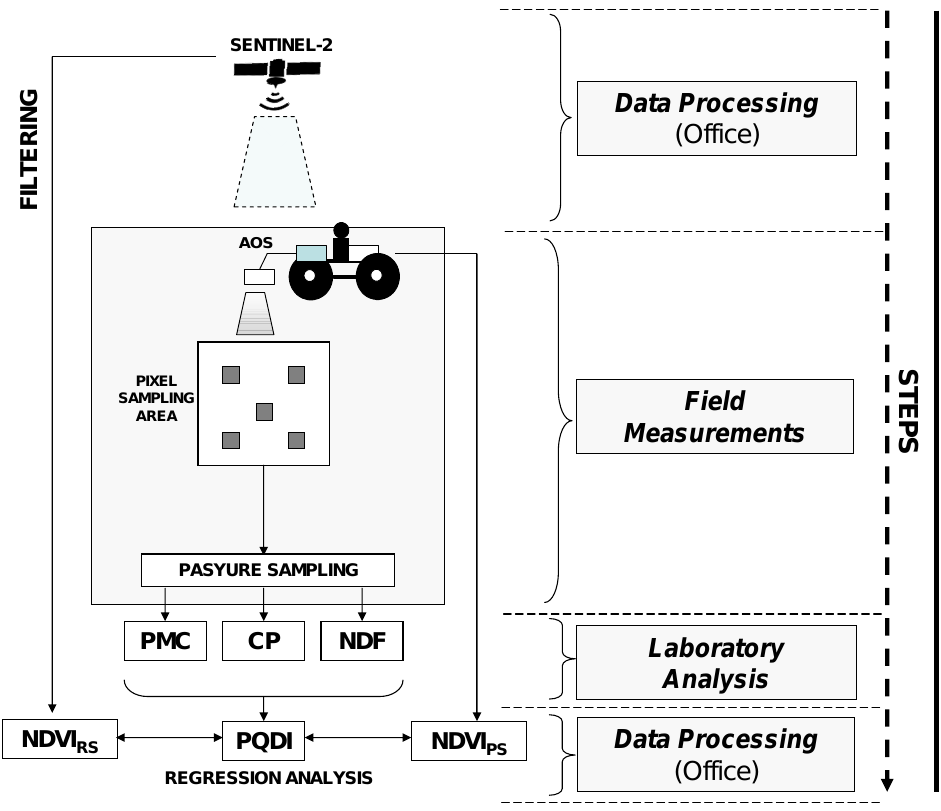
Figure 8. Flowchart of the various data collection and processing